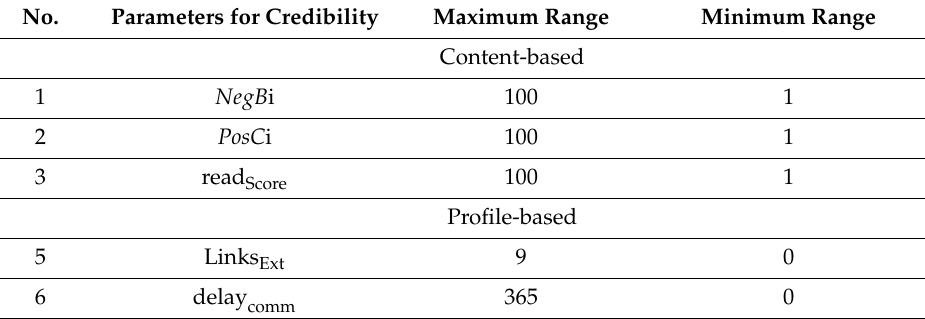
Table 6. The value ranges for each credibility